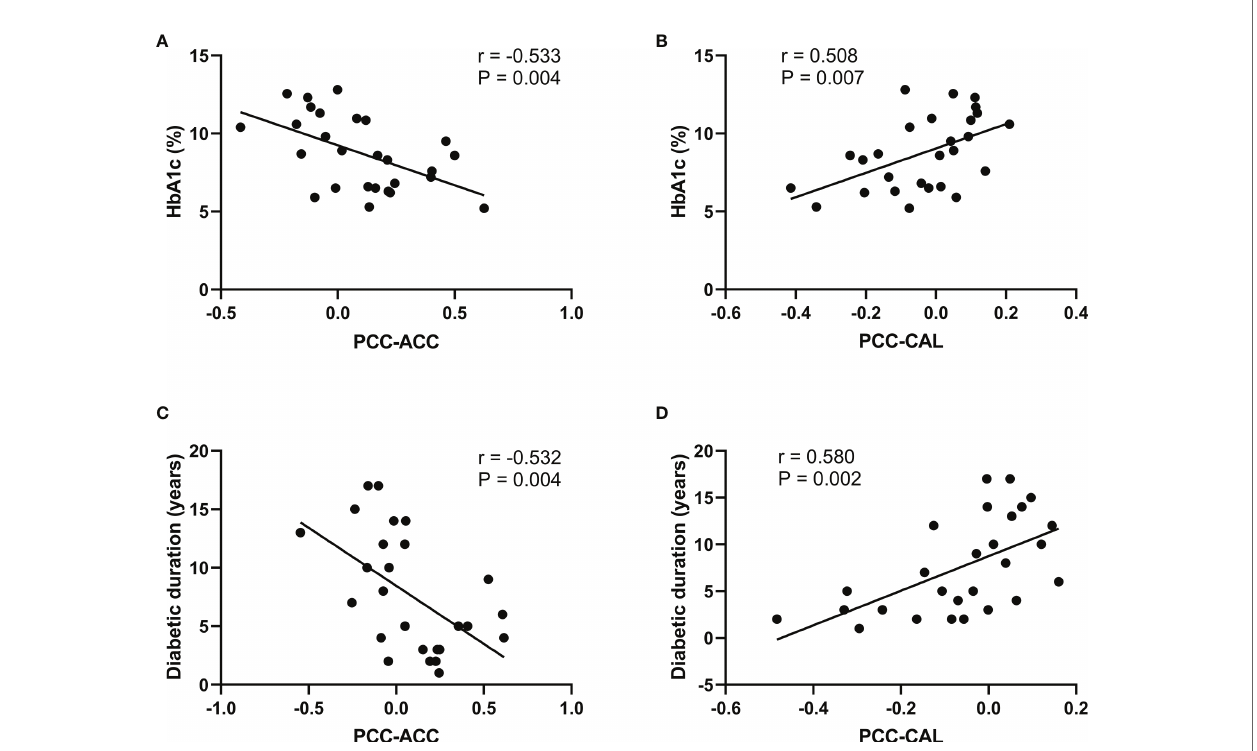
FIGURE 5 | Signi fi cant correlations between the functional connectivity and different clinical variables in type 2 diabetes patients without cognitive and microvascular complications. (A) Correlation between the glycosylated hemoglobin (HbA1c) level and the functional connectivity of the posterior cingulate cortex and anterior cingulate cortex (PCC-ACC) ( r = − 0.533, p = 0.004). (B) Correlation between the HbA1c level and the functional connectivity of the PCC and calcarine fi ssure (CAL) ( r = 0.508, p = 0.007). (C) Correlation between diabetes duration and the functional connectivity of PCC-ACC ( r = − 0.532, p = 0.004). (D) Correlation between diabetes duration and the functional connectivity of PCC-CAL ( r = 0.580, p =